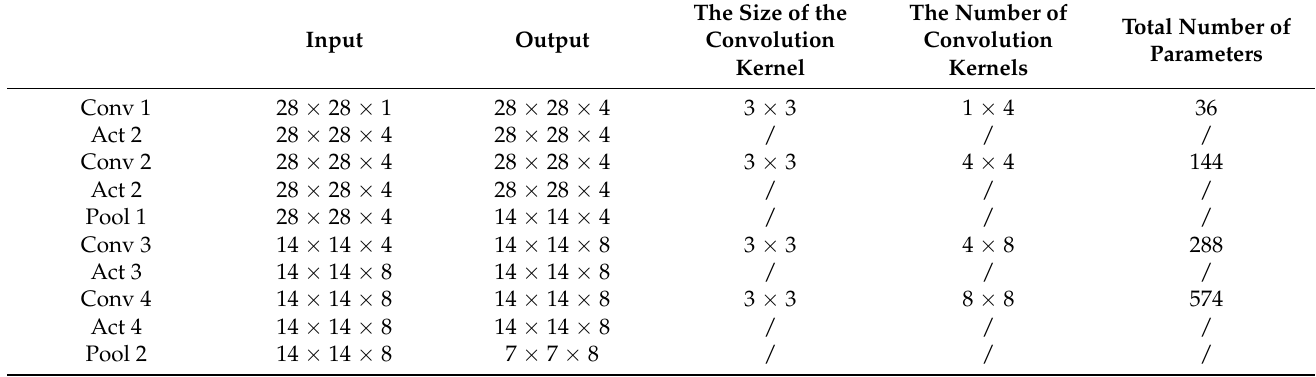
Table 1. Statistics of each parameter in the